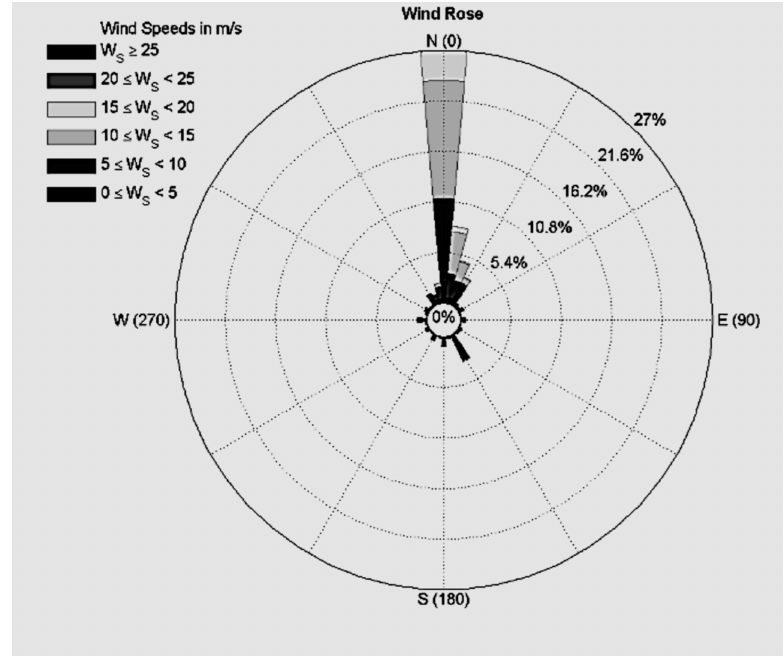
Figure 5. Wind Rose